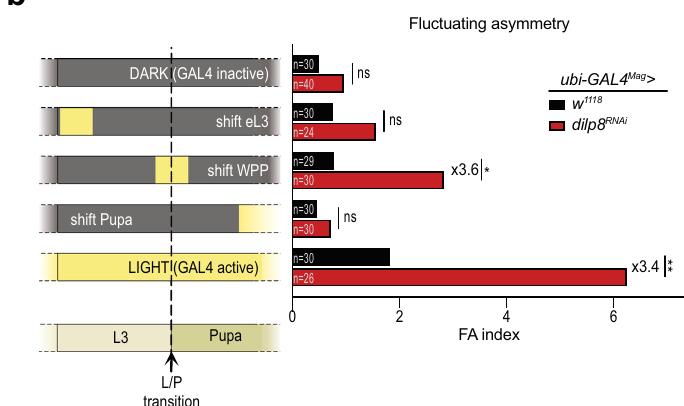
switched to white tube light to activate the GAL4/UAS system and downregulate dilp8 . Chronic dark and light are the negative and positive controls, respectively. The graph on the right shows the FA indexes measured for adult pairs of wings of the given genotypes after the corresponding shift protocol. This experiment was performed at 29°C. n values indicate the number of independent wing pairs ana- lyzed; ** p =0.0047, * p =0.0489 and ns=not signi fi cant, Levene ’ s tests. AED after egg deposition, APF after pupa formation, L/P transition: larva-to-pupa transition, WPP white prepupa, eL3 early L3 stage. Source data are provided as a Source Data fi